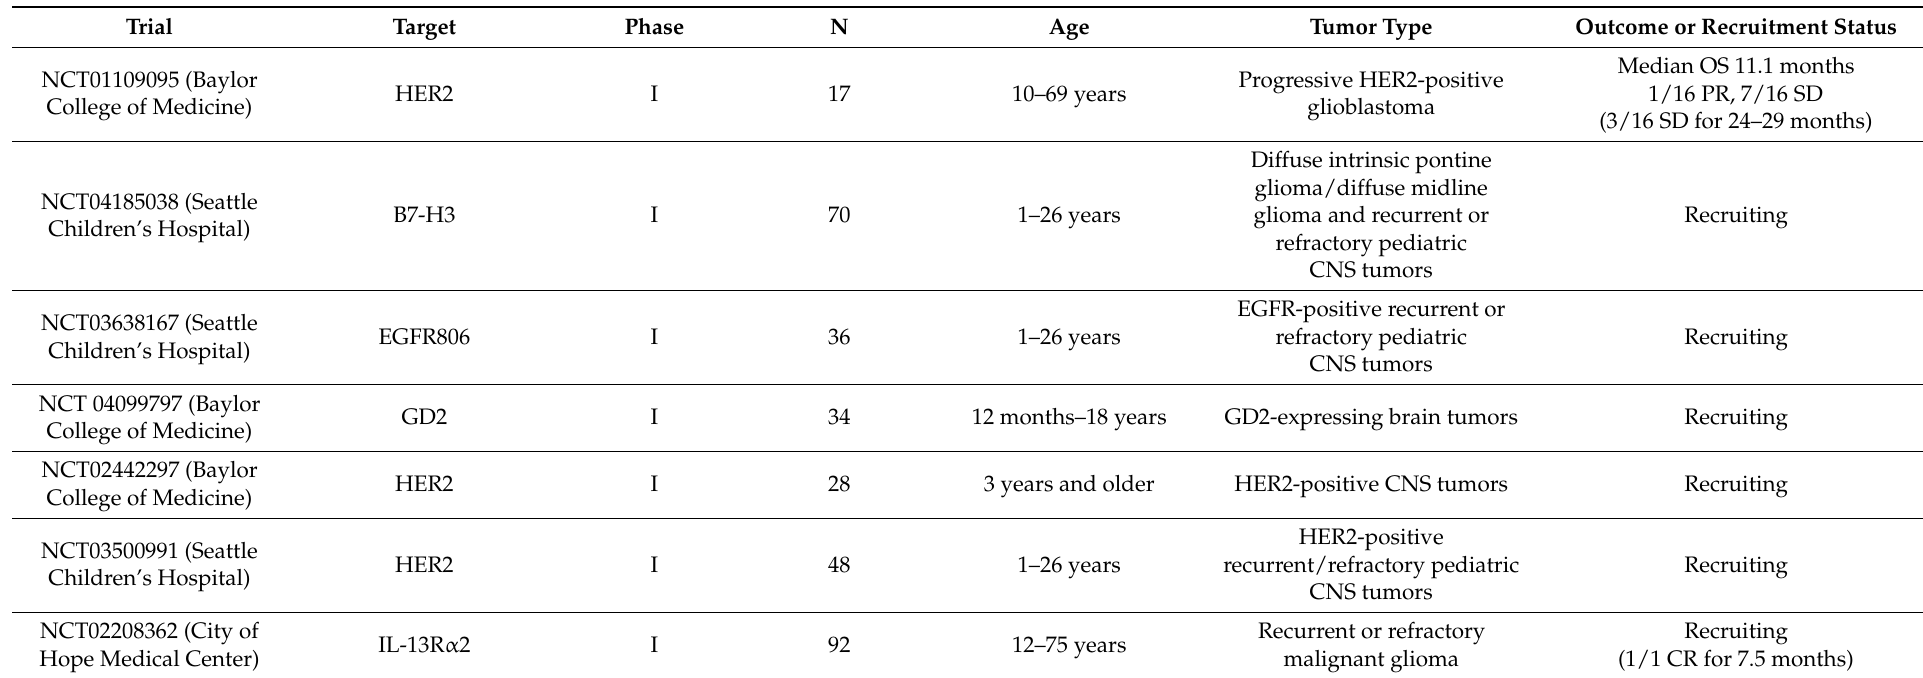
Table 1. Published and ongoing clinical trials with CAR T-cell therapy for pediatric brain